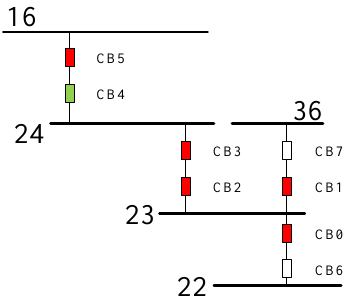
Figure 5. Fault area and breaker state diagram.